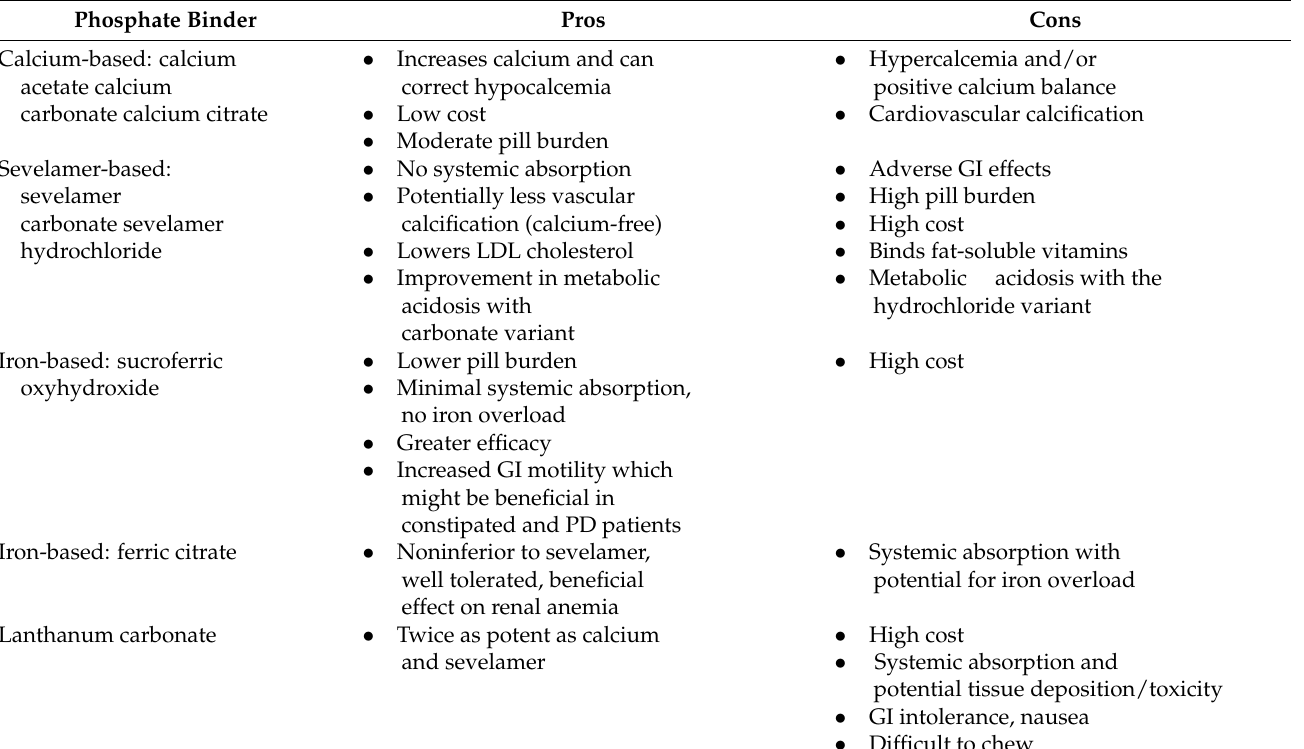
Table 2. Comparison of phosphate binders in chronic kidney